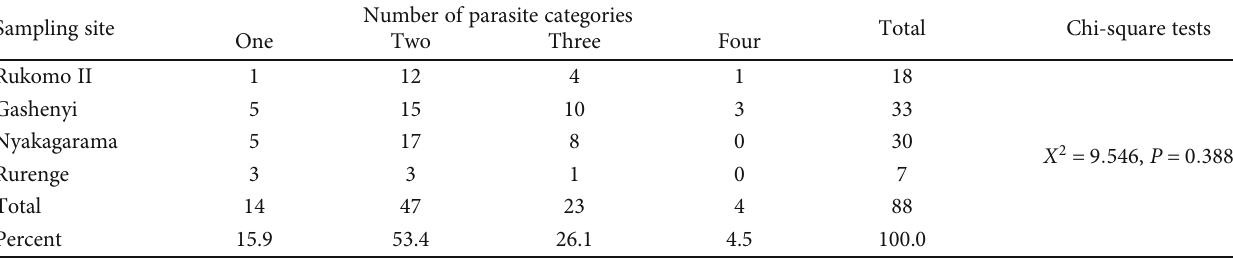
Table 3: Number of parasite categories detected per infected study pig according to sampling sites ( n = 88